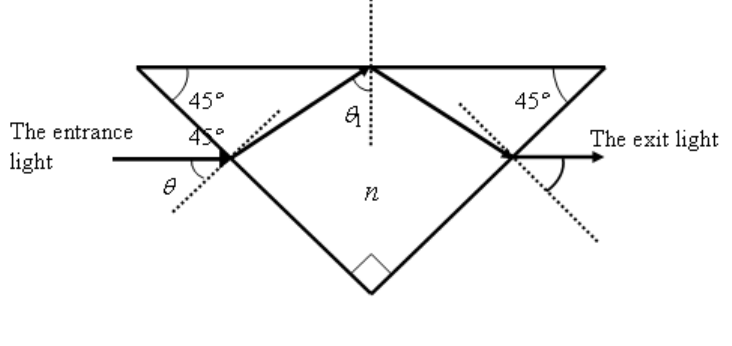
Figure 1. A ray of light in air incident at θ on one side surface of a right-angle prism with refractive index n